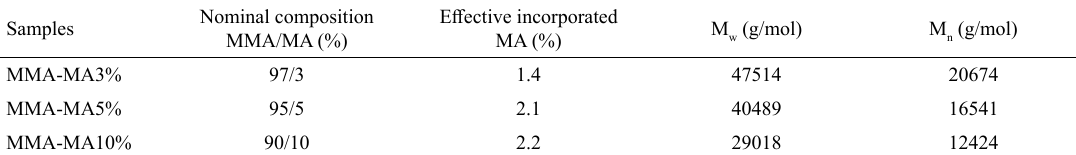
Table 1. Structural and compositional properties of MMA-MA synthetized with different MA content.